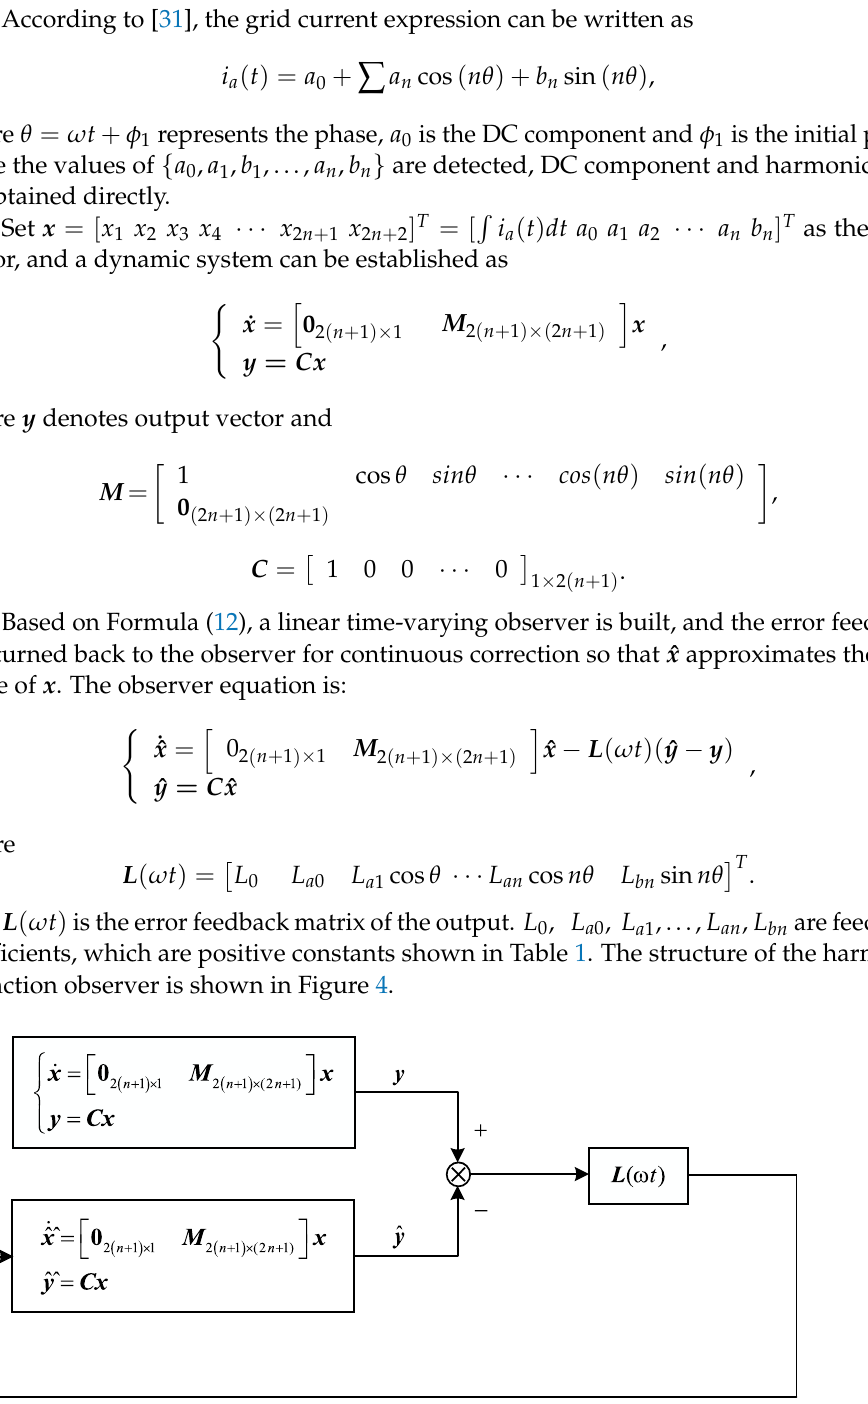
Figure 4. Block diagram of the harmonic extraction